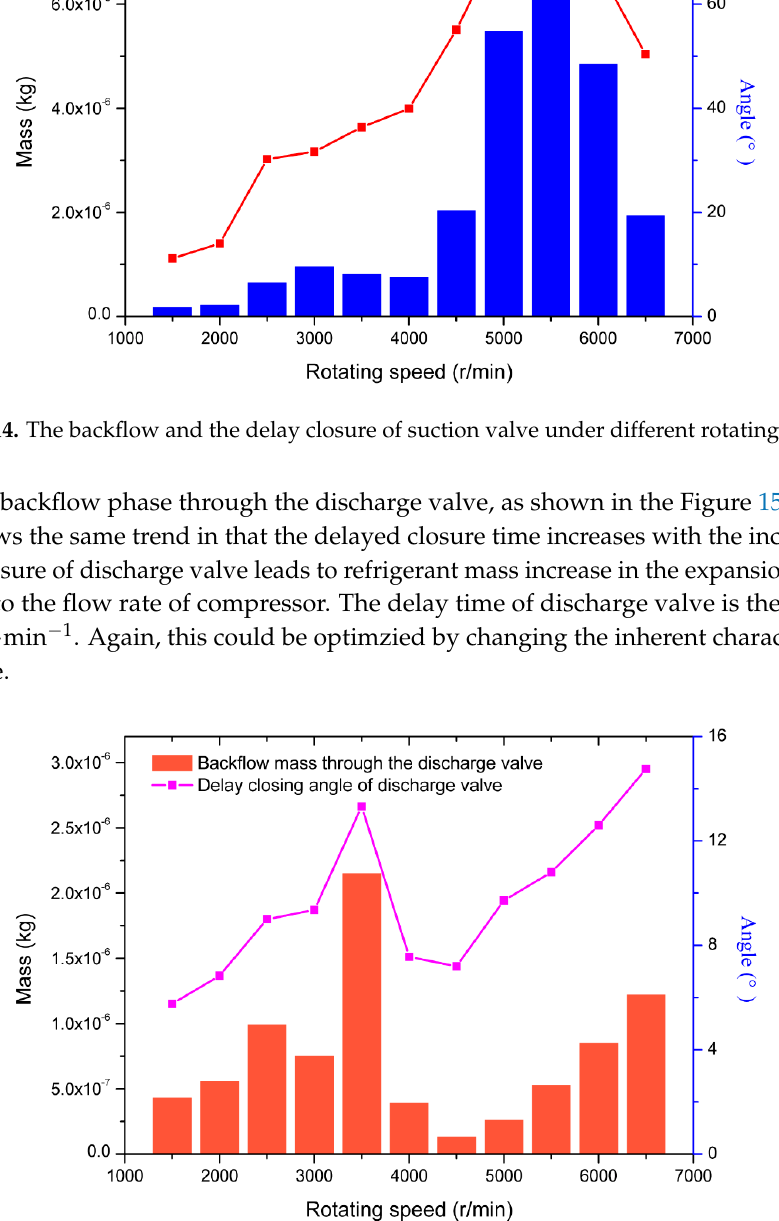
Figure 15. The backflow and the delay closure of discharge valve under different rotating speed.